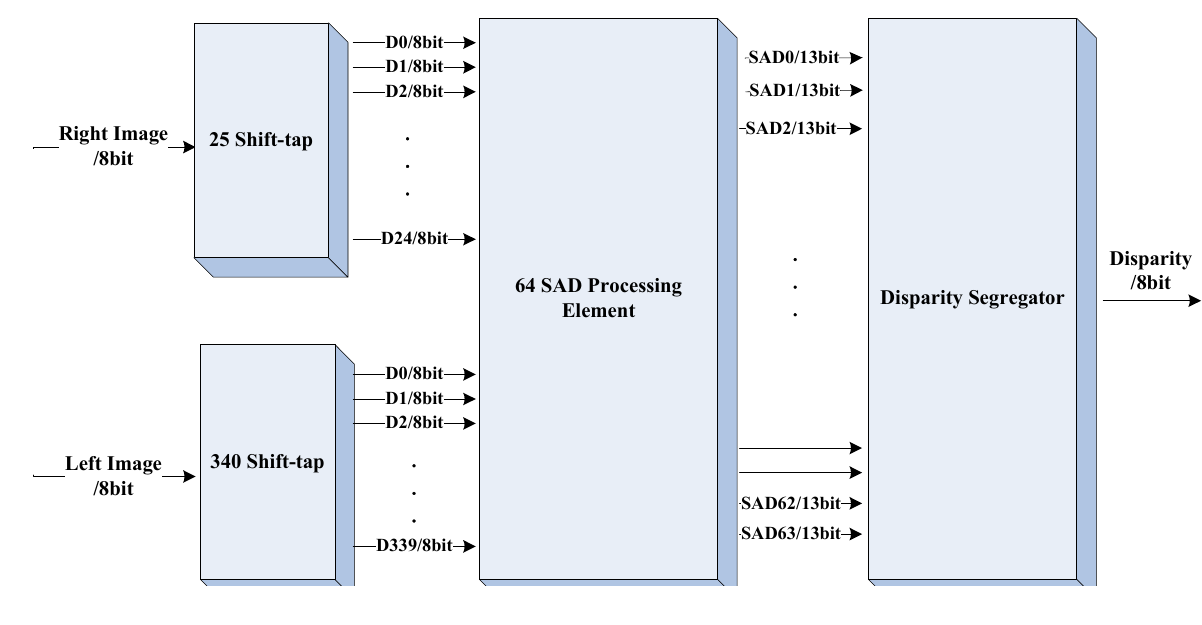
Figure 5. Layout Plan of the Parallel SAD